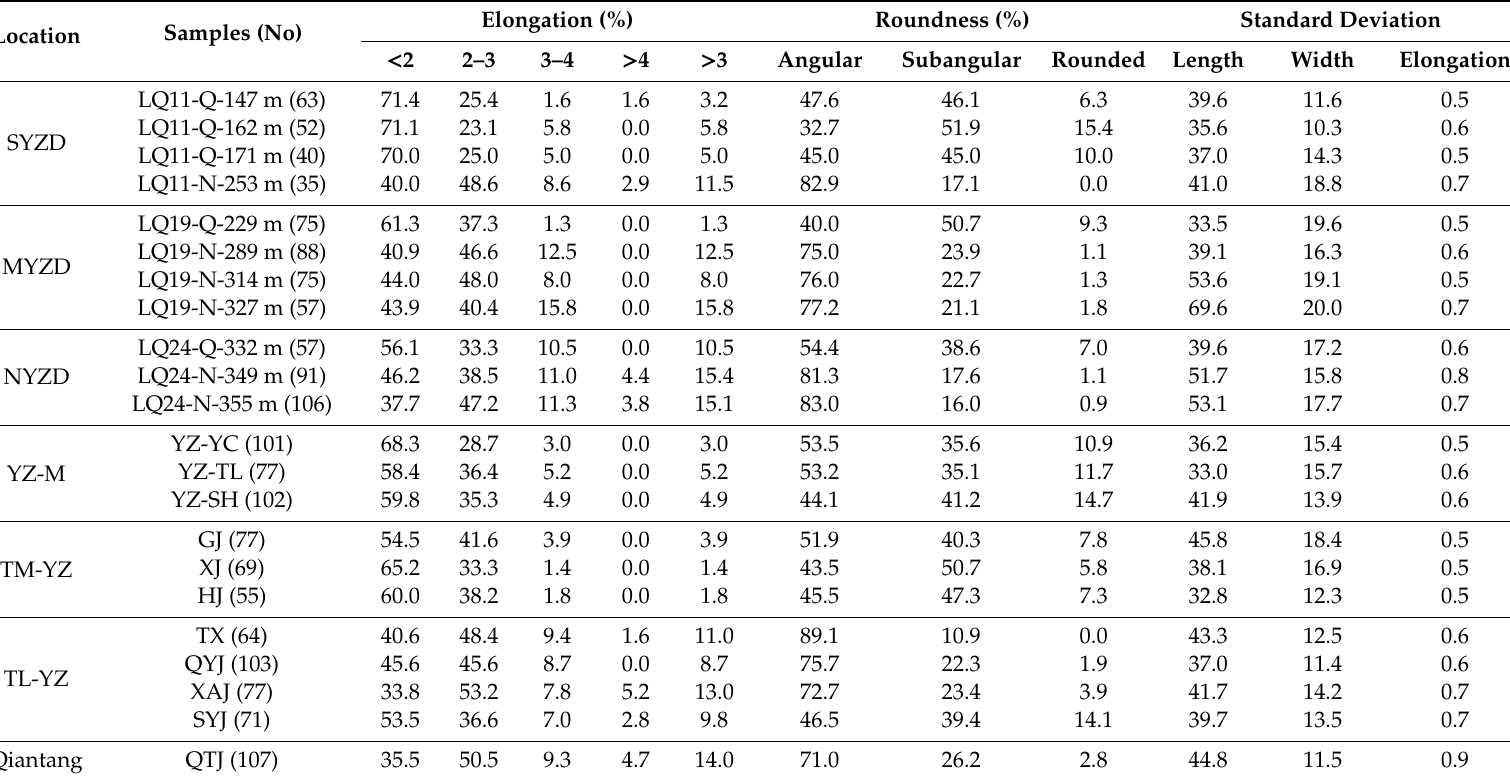
Table 1. Elongation and roundness statistics of detrital zircon in modern rivers and core samples of the Yangtze Delta. Q = Quaternary, N = Pliocene, NYZD = North = Modern tributaries of the Lower Yangtze. Please see Figure 1 for the explanation of the abbreviations of some place